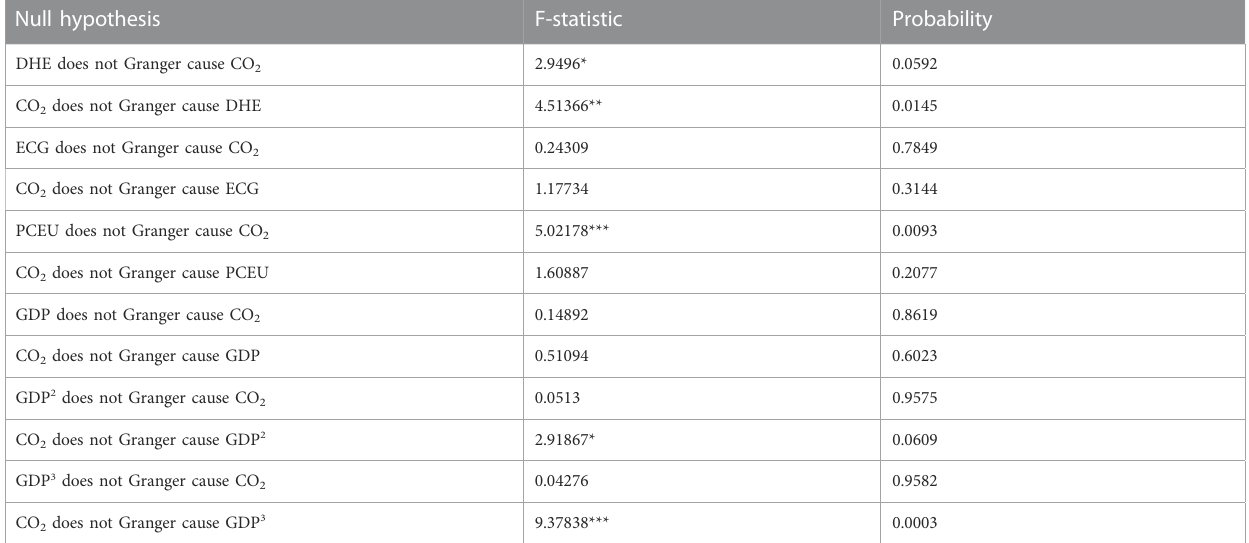
TABLE 7 A causality